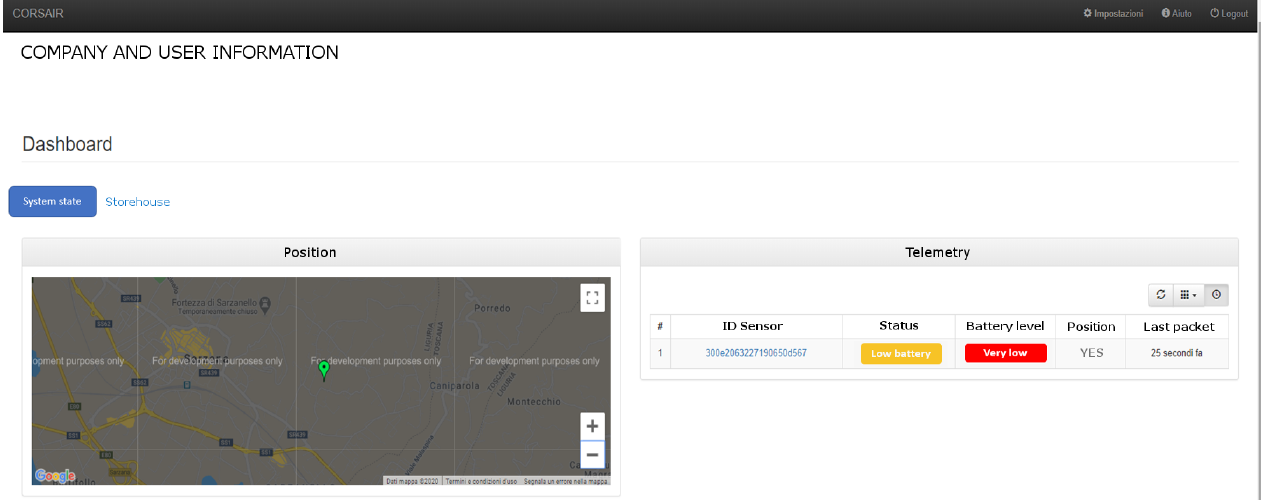
Figure 5. Web-based User Interface of data gateway to monitor the information coming from all company’s sensors.